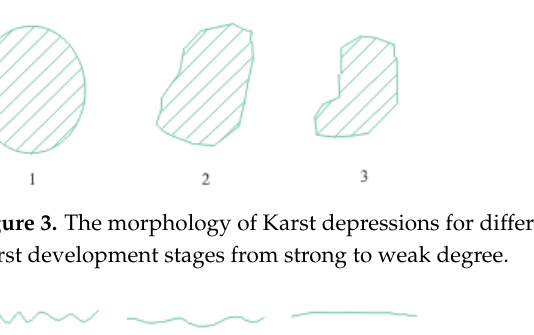
Figure 4. The morphology of contour for different Karst stages 1, 2, and 3 represent three Karst development stages from strong to weak degree.